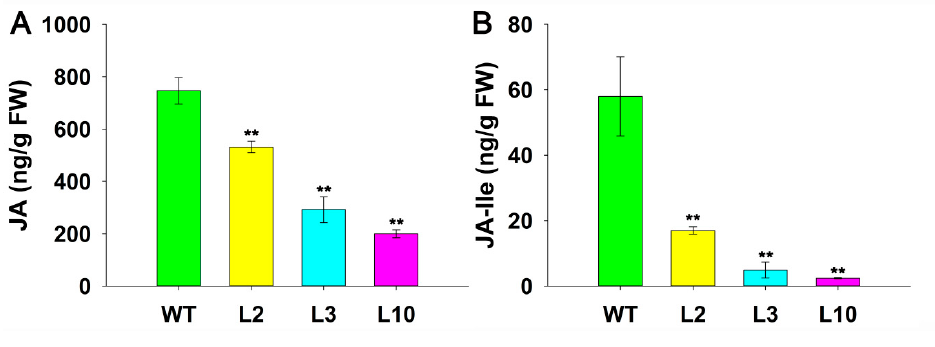
Figure 11. Contents of JA ( A ) and JA-Ile ( B ) in early developing inflorescences from the wild type (WT) and the transgenic Jatropha plants. FW, fresh weight; JA, jasmonic acid; JA-Ile, jasmonic acid-isoleucine. Error bars represent the standard deviations ( n ≥ 3). Student’s t -test was performed to analyze significant differences. ** Extremely significant difference ( p < 0.01).